Question: Looking at the figure, what chart type is it?
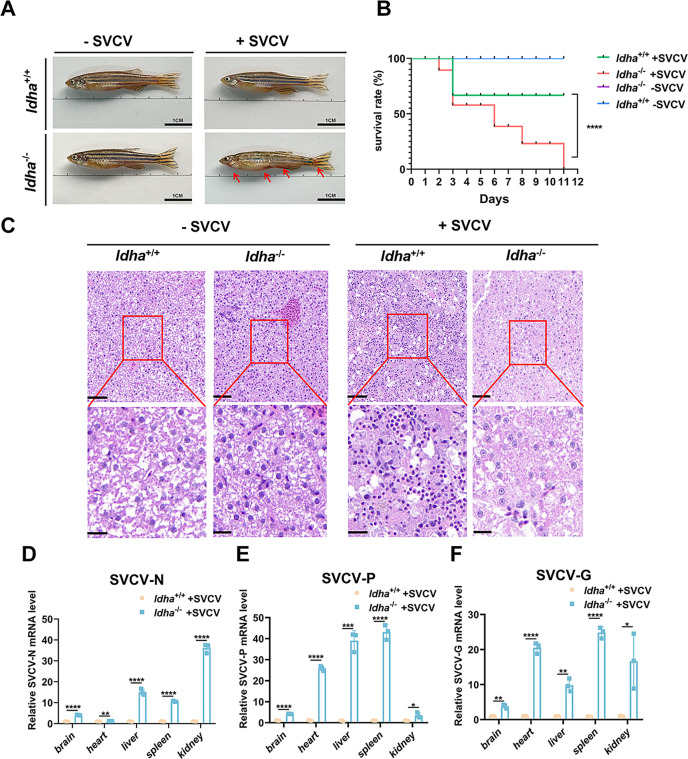
Answer: survival